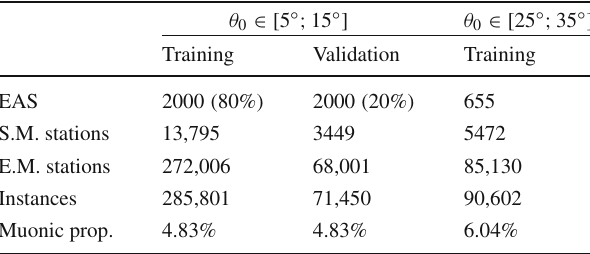
Table 1 Number of stations with single muons (S.M. stations) and withoutmuons(E.M.stations)ofthetrainingdatasets.Datasetscreated with primary energy E 0 ∈ [4 ; 6] TeV and the dense array. A validation data set was created using a 20% of the stations from the original 2000 vertical